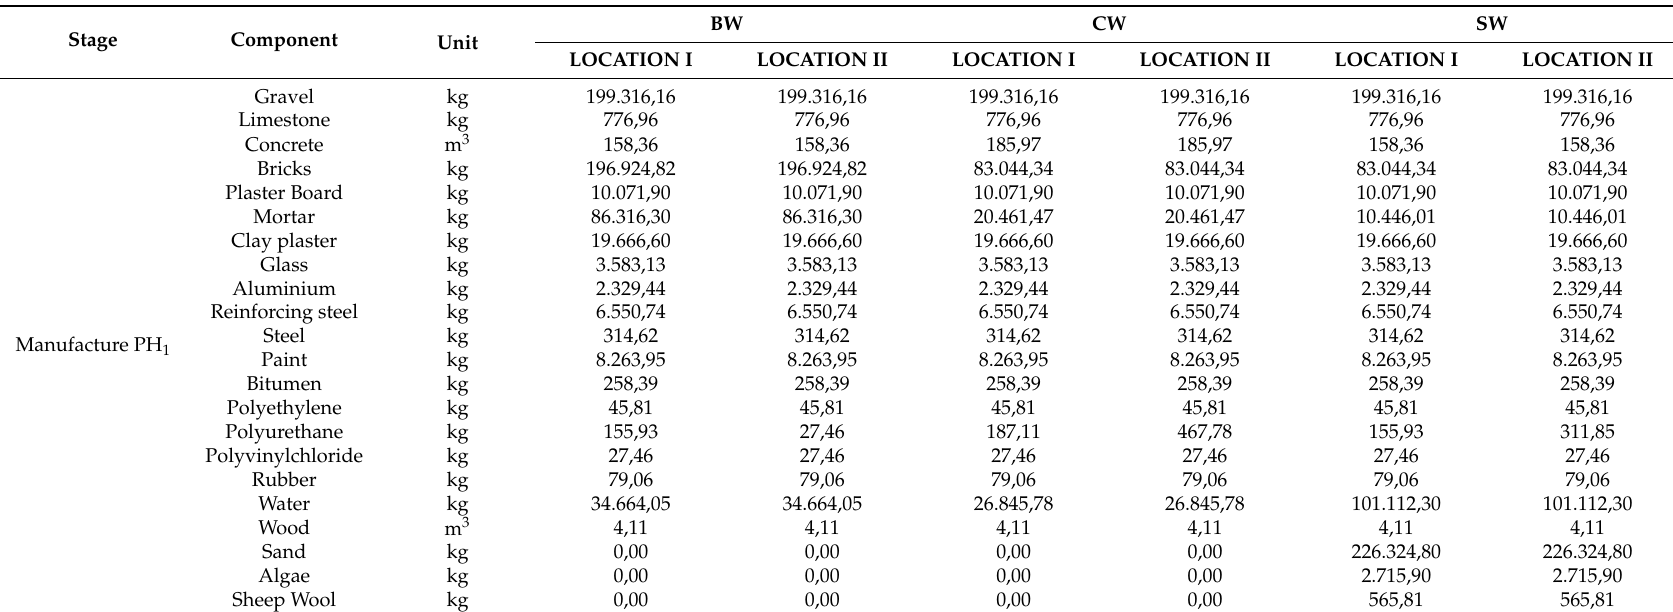
Table 4. Inventory list of the materials used for every type of building system and